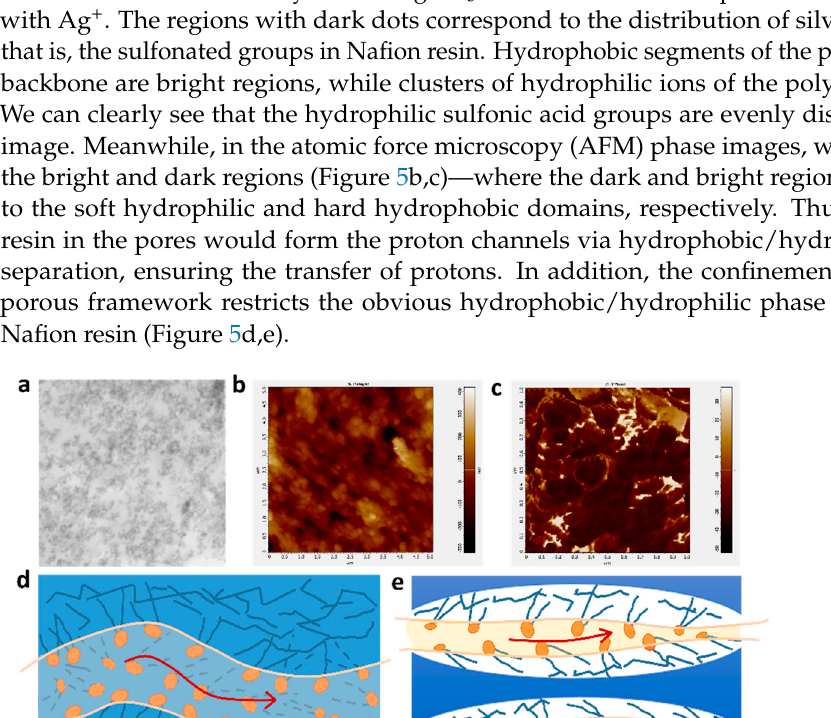
8 membrane; The schematic diagram of hydrophilic ion channels in ( d ) Nafion and ( e ) D ‐ DMAc membranes.